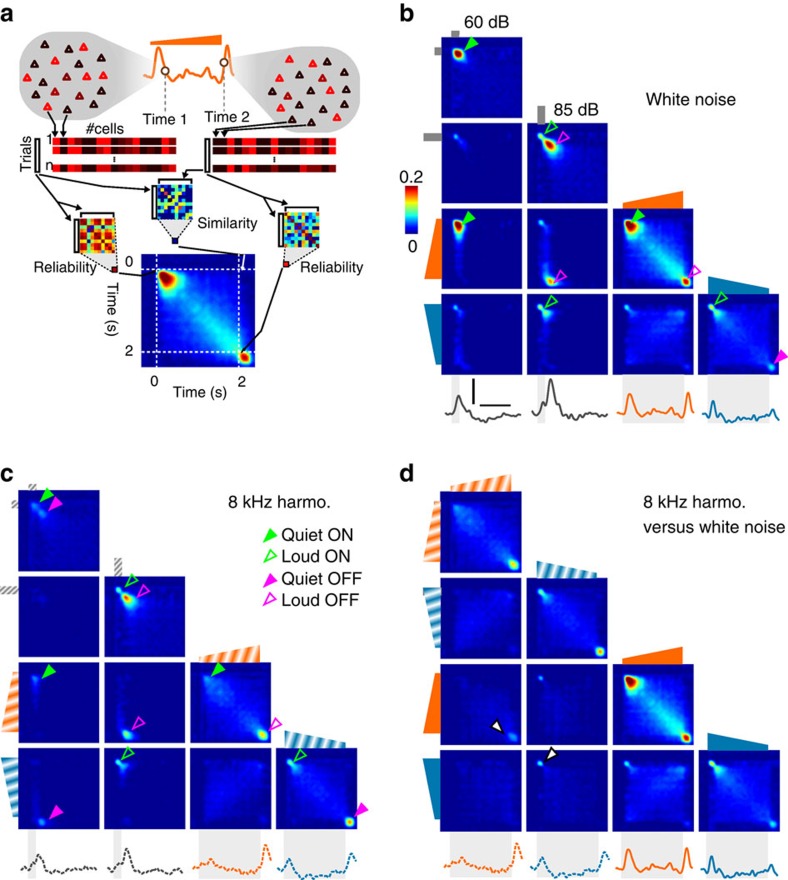
Cortical population dynamics during up- and down-ramps.(a) Schematic of the population vector similarity measure (Methods). For this analysis, we pooled all recorded neurons in a pseudo-population. The similarity between two population activity patterns (for example, patterns at time 1 and 2 post stimulus) corresponds to the average of all pair-wise correlations computed across single-trial population vectors. The reliability of a pattern is computed identically based on correlations computed across all single-trial occurrences of this pattern. (b) Population similarity matrix across time bins and stimuli for four white noise sounds (60 and 85 dB 0.25 s duration and 60–85 dB 2 s duration up- and don-ramps). Underneath the population firing rate waveforms are shown. The arrowheads on the diagonal indicate distinct activity patterns identified as ‘Quiet ON' (filled green), ‘Loud ON' (empty green), ‘Quiet OFF' (filled magenta) and ‘Loud OFF' (empty magenta). Arrowheads off the diagonal indicate strong similarities between different responses (for example, empty magenta arrowhead indicates similarity between ‘Loud OFF' activity patterns observed after the 85 dB 250 ms sound and after the 60–85 dB up-ramp). Scale bars, vertical 0.4% ΔF/F, horizontal 1 s. (c) Same as b for the harmonic 8 kHz tone. (d) Same as b and c, but the response to the white noise and 8 kHz ramps are compared.